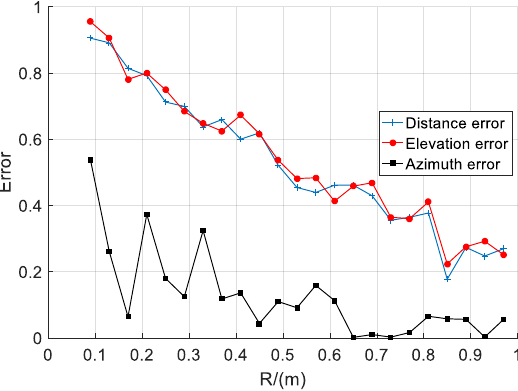
Figure 3. Relationship between array radius and localization error.